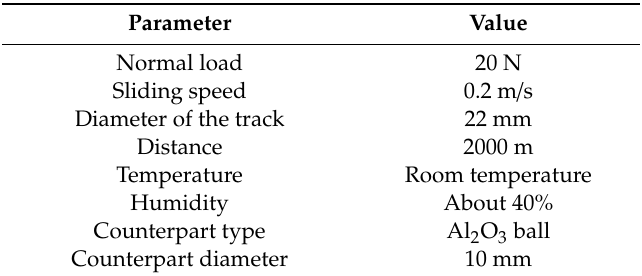
Table 2. Parameters applied in ball-on-disc